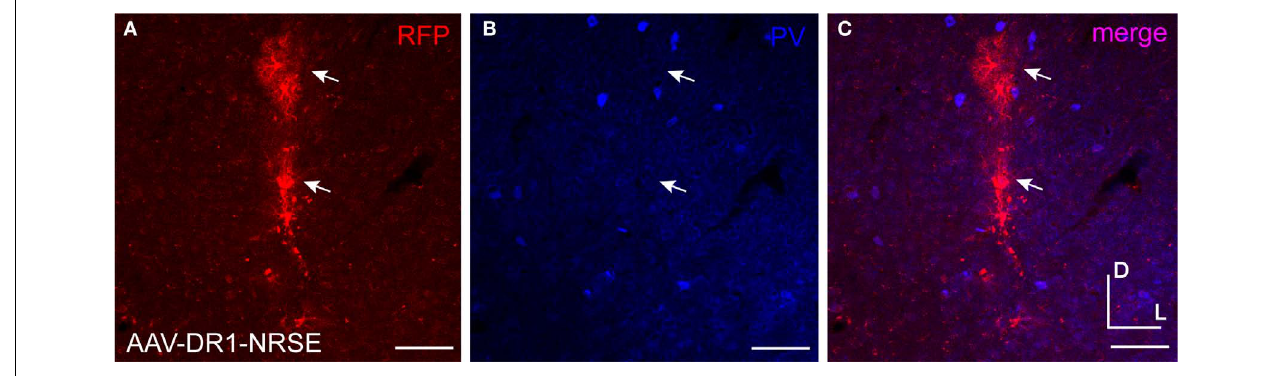
FIGURE 12 | AAV-DR1-NRSE drove expression in only a few cells. AAV driven by the composite regulatory element promoter containing DR1 and NRSE motifs (AAV-DR1-NRSE) was injected into mouse somatosensory cortex. Expression of the RFP AAV transgene is shown